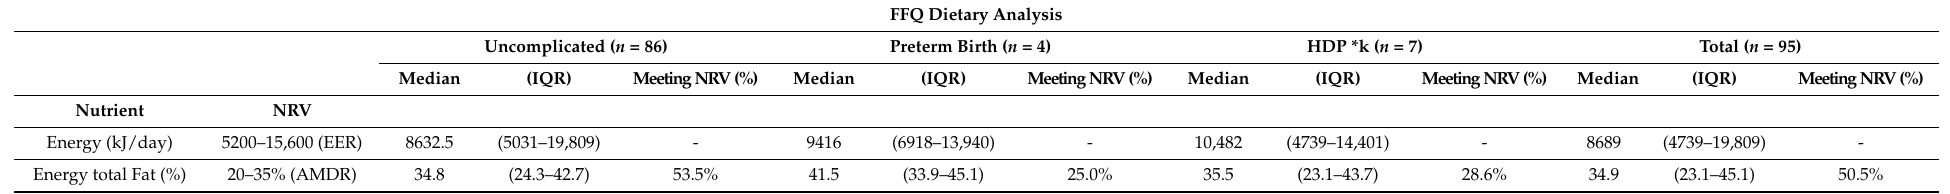
Table 4. Comparison of nutrient intake from foods of Indigenous pregnant women in the Gomeroi Gaaynggal cohort with or without a preterm birth or hypertension during pregnancy, as recorded by food frequency questionnaire during the third